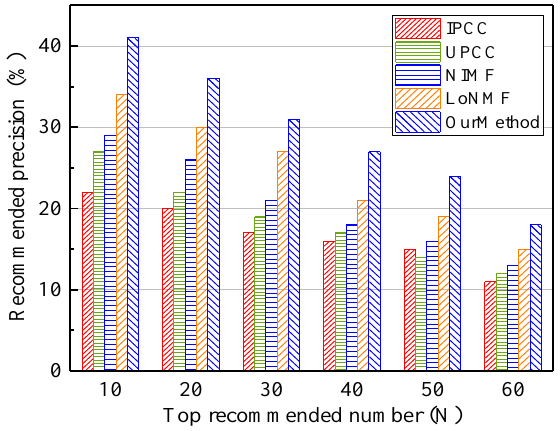
Figure 9. Comparison results of recommended precision.